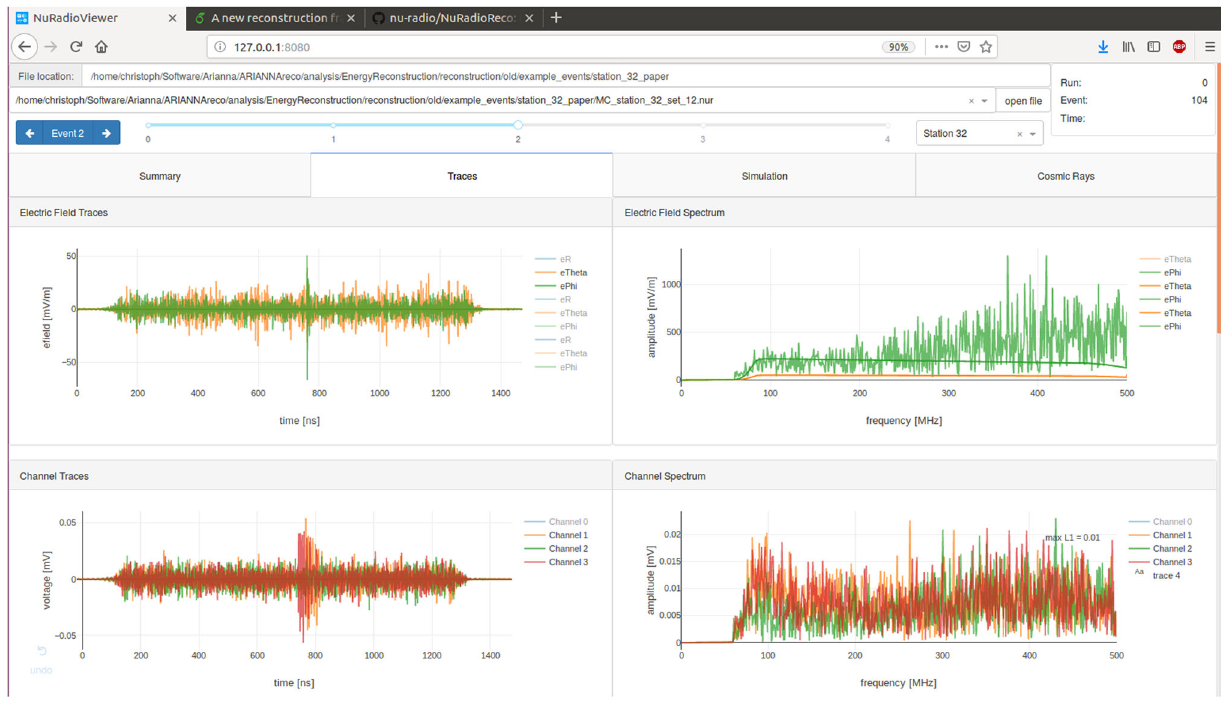
Fig. 6 Screenshot of theEventBrowser. TheEventBrowser canbe ren- dered in any modern web browser. Panels at the top switch between various summary figures (e.g. pulse amplitude as function of time), individual event data and if present simulated and cosmic-ray related